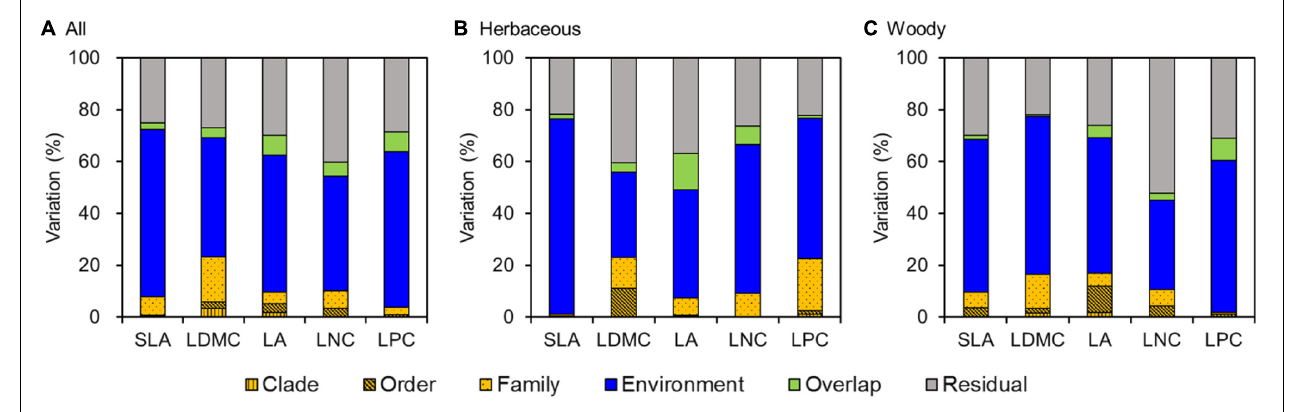
FIGURE 5 | Variance partitioning for leaf traits using a phylogenetic linear mixed model (PLMM) for (A) all species, (B) herbaceous species, and (C) woody species. SLA, specific leaf area; LDMC, leaf dry matter content; LA, leaf area; LNC, leaf N concentration; LPC, leaf P